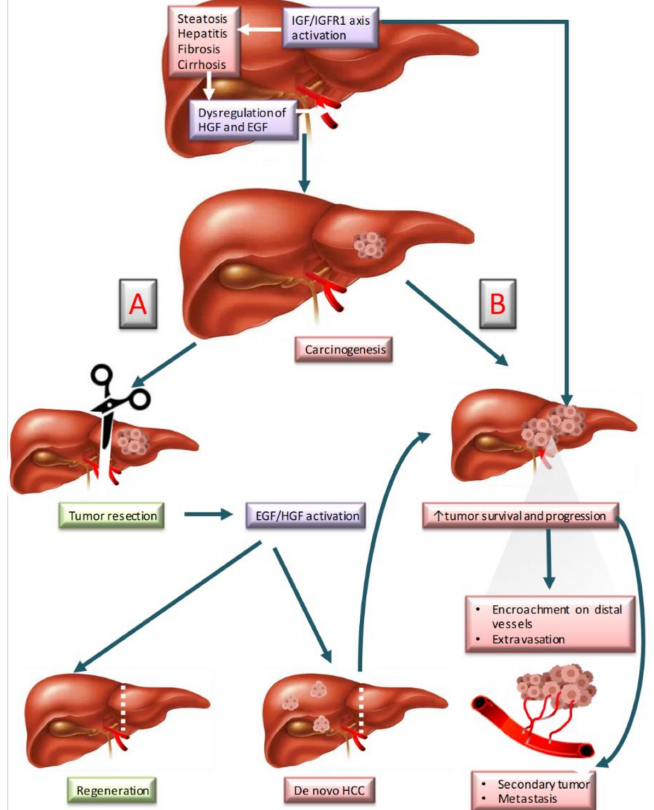
Figure 1. Liver carcinogenesis and regeneration involving HGF, IGF-1, and EGF. ( A ) Normal regener- ation after resection. ( B ) Cancer recurrence after resection. Abbreviations: EGF; epidermal growth factor; HCC, hepatocarcinoma; HGF, Hepatocyte growth factor; IGF-1, Insulin-like growth factor-1; IGFR-1, Insulin-like growth factor